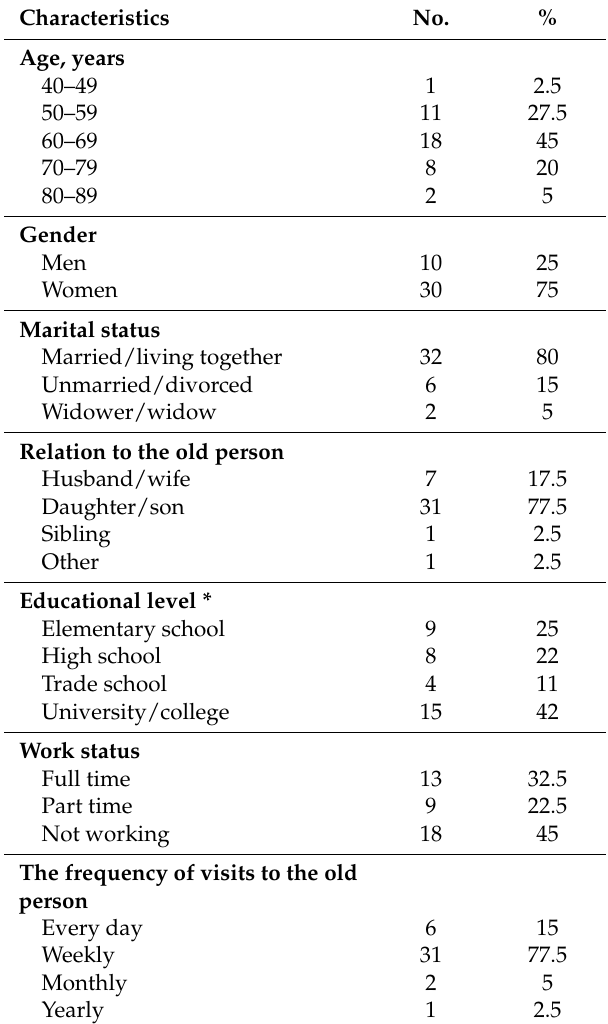
Table 1. Characteristics of the participating next of kin ( n =